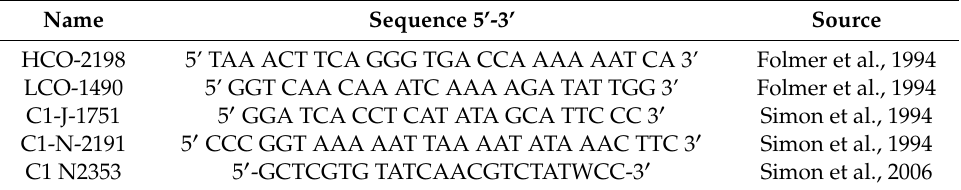
Table 1. List of used primers to amplify the cytochrome c oxidase I (COI)